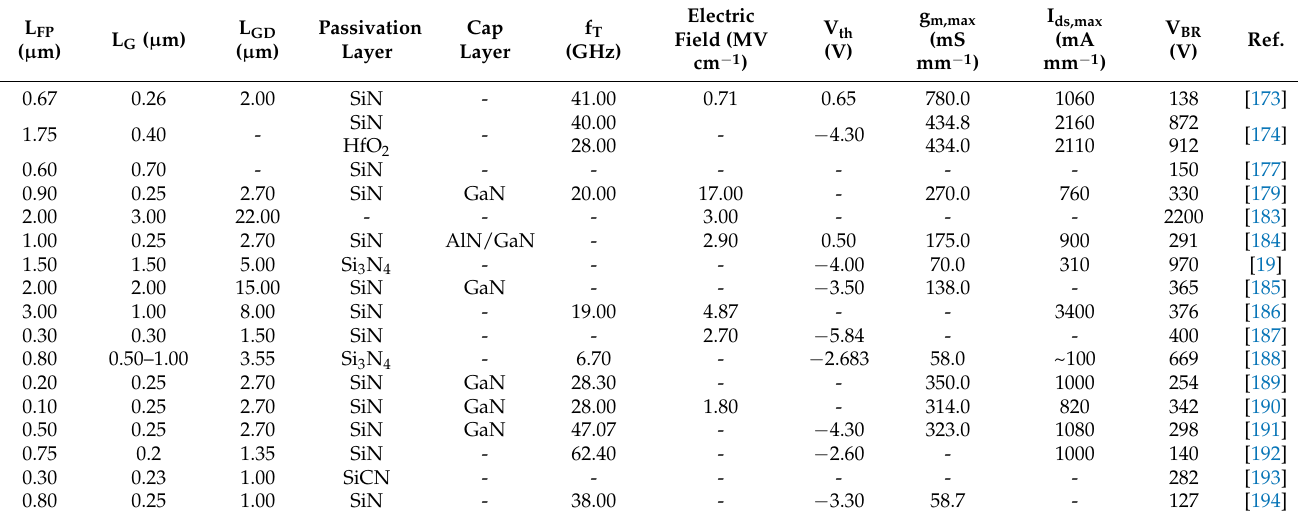
Table 6. Comparison of output characteristics of GaN-based HEMTs with